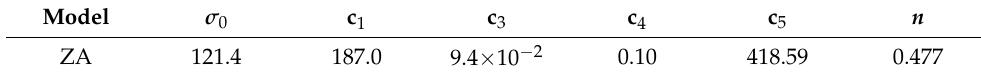
Table 2. The fitting results of each parameter of the constitutive equation in ZA model.